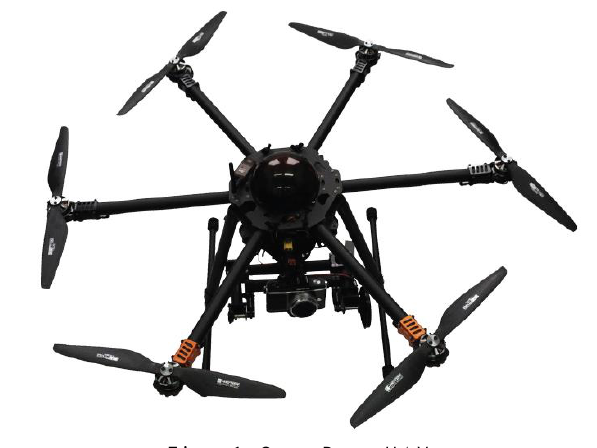
Figure 1. SurveyDrone UAV Georeferencing was done through the use of ground control points. They were signalized by black circular targets on a white background. A tachymetric total station was used to determine positions of ground control points and to perform tachymetric control measurements of landslide dynamics. Some of tachymetric control points were stabilized as tachymetric reflector mounts drilled into larger boulders on the landslide, others as reflector mounts mounted onto steel rods and stabilized into the landslide